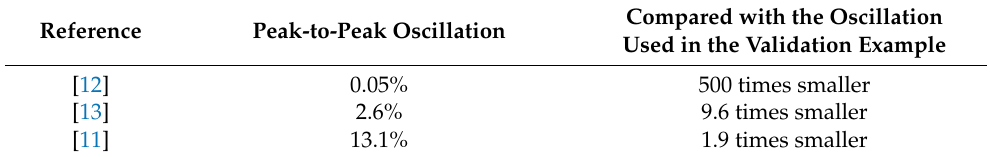
Table 4. Examples of DC-link oscillations reported in literature.